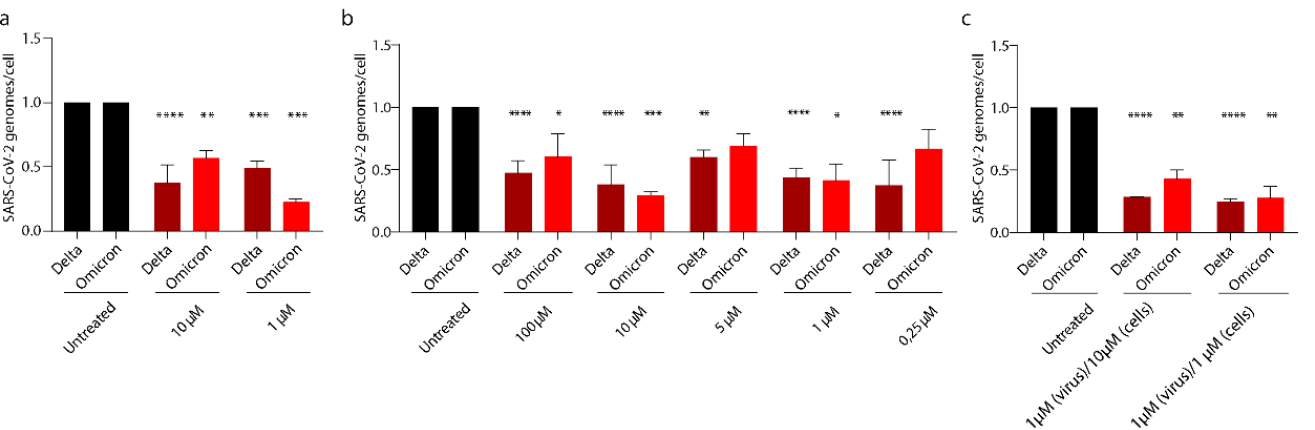
Figure 8. PEA exerts antiviral activity on SARS-CoV-2 VOCs. SARS-CoV-2 relative quantity in ( a ) cells infected with PEA-incubated SARS-CoV-2, ( b ) cells treated or not with PEA, ( c ) both SARS-CoV-2 and cells treated with PEA. Intracellular viral RNA was normalized using β -actin as a housekeeping gene. Data are expressed as means ± SD and were analyzed using a one-way ANOVA (n = 3, * p < 0.5, ** p < 0.01; *** p < 0.001, **** p < 0.0001).